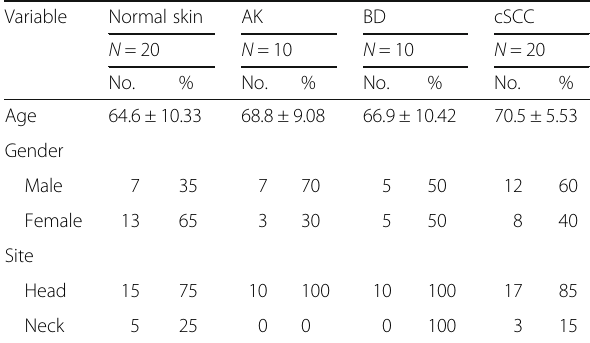
Table 1 Clinical data of studied cases Variable Normal skin